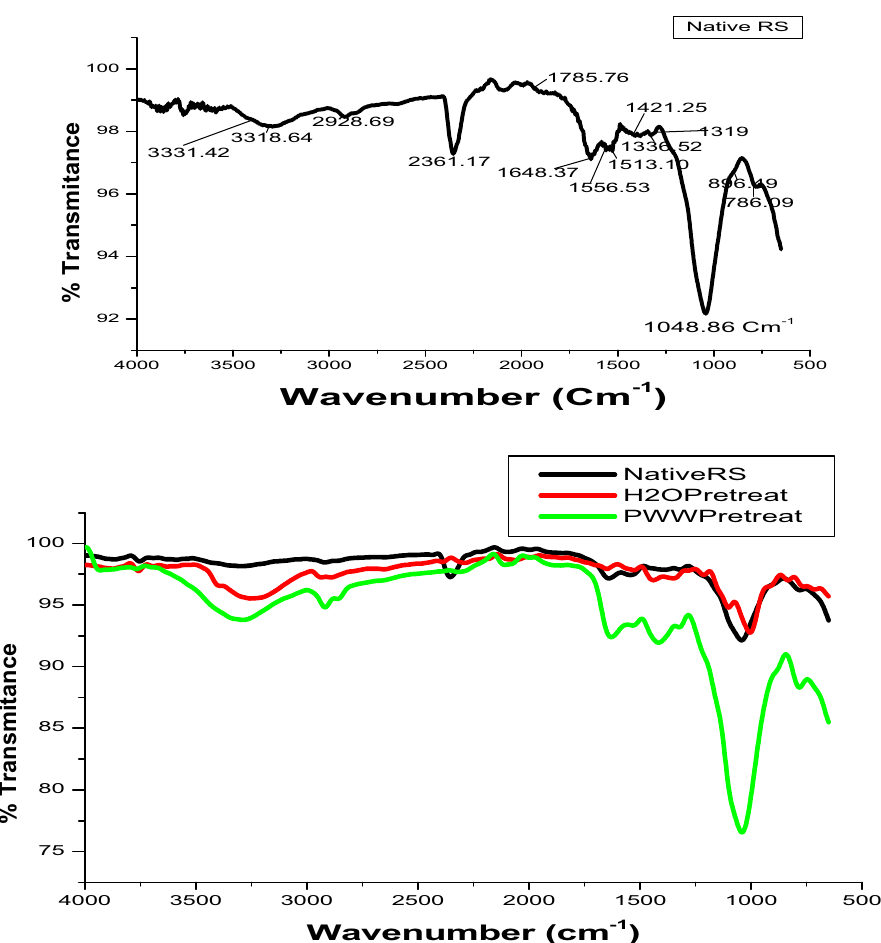
Figure 3. FTIR spectrum of native, PWW pretreated and distilled water (H 2 O) pretreated RS.